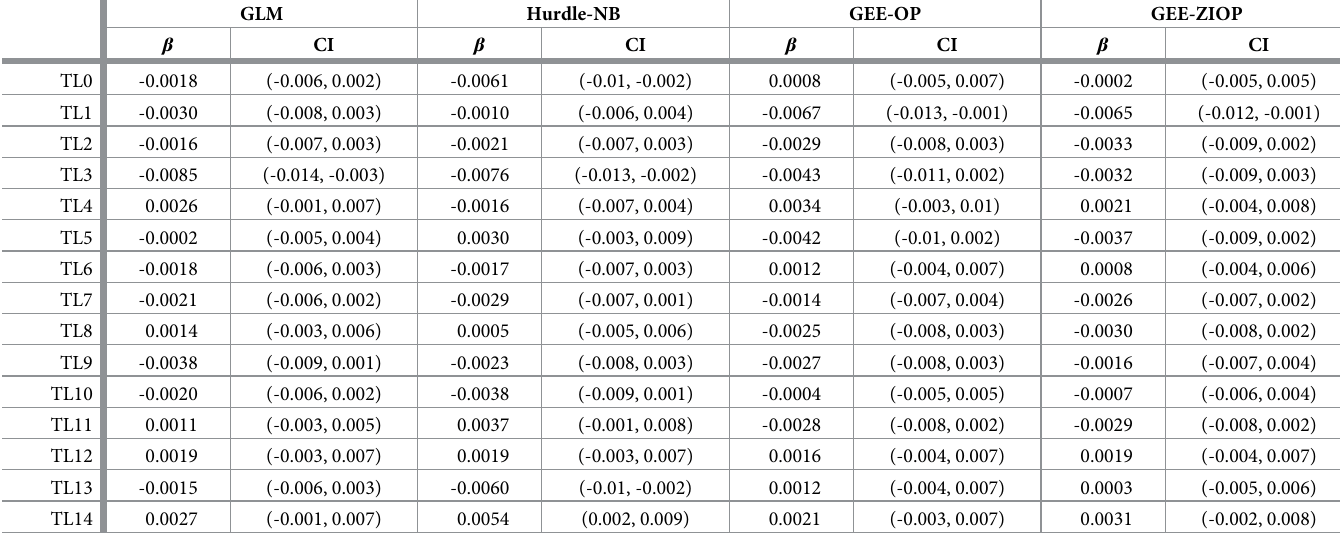
Table 3. Temperature coefficients and 95% confidence